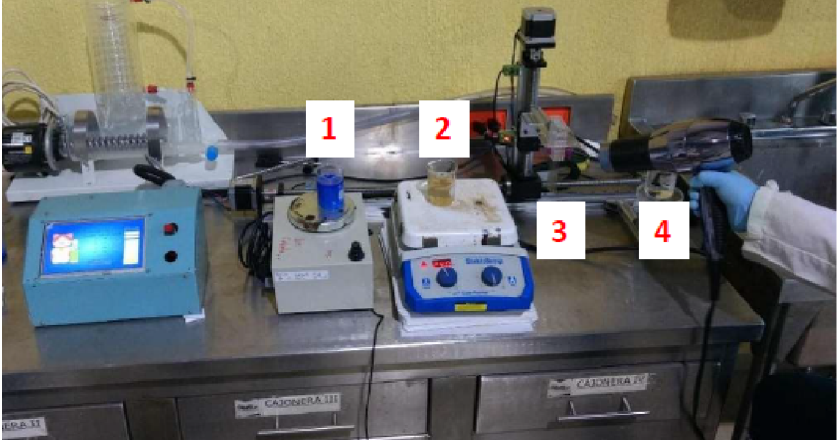
Figure 17. Experiment with the Automated SILAR prototype for the deposition of copper oxide thin films (CuO).